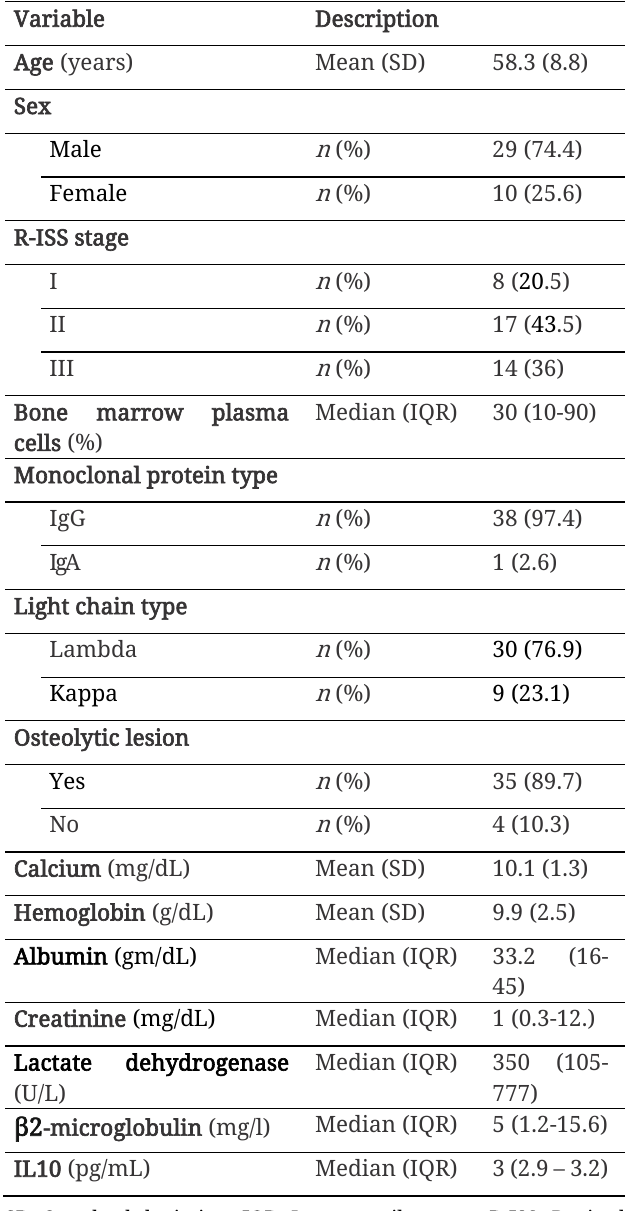
Table 1: Demographic and clinical characteristics of 39 patients with multiple